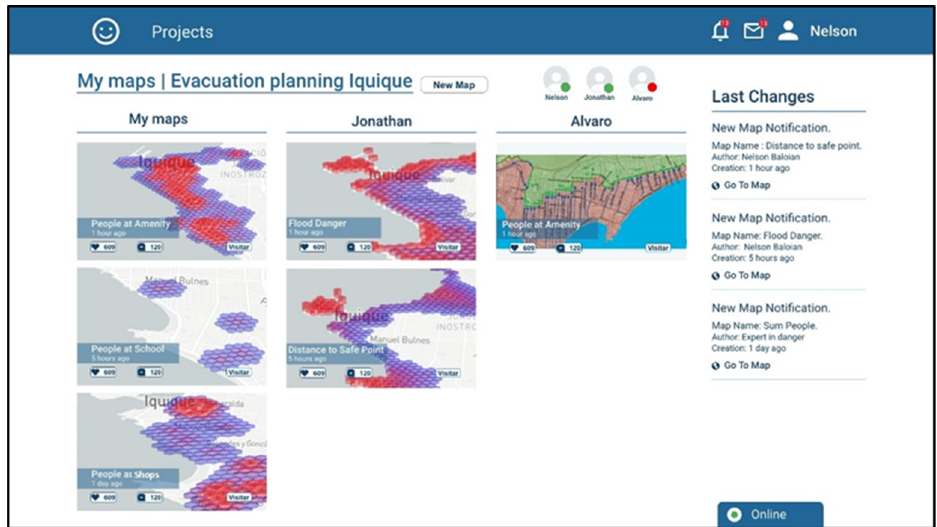
Figure 4. Screenshots of the application showing the available projects for user Nelson.